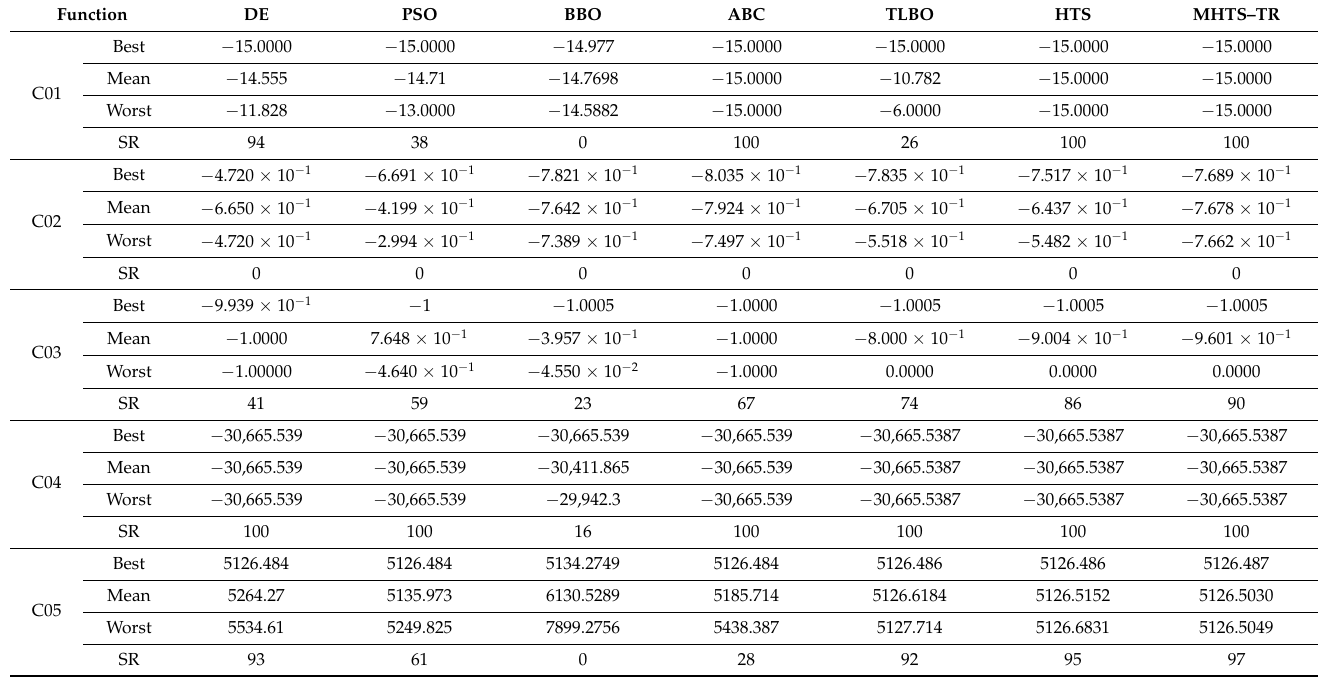
Table 2. Computational results of C01–C13 for the MHTS–TR method with other MHAs. (The experimental results of the competitor algorithms are derived from the literature